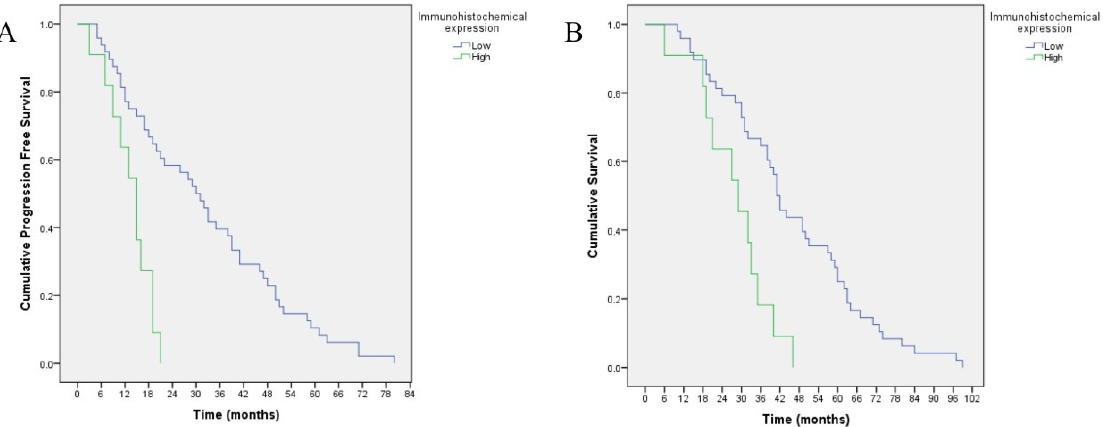
Figure 3. Kaplan–Meier estimates for survival according to HDAC-2 immunohistochemical expres- sion. ( A ): Disease-free survival. ( B ): Overall survival.